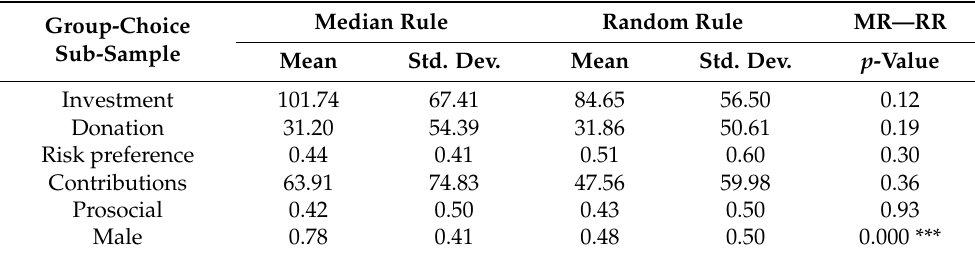
Table 3. Descriptive statistics for the group-choice sub-sample: Median rule (MR) vs. Random rule